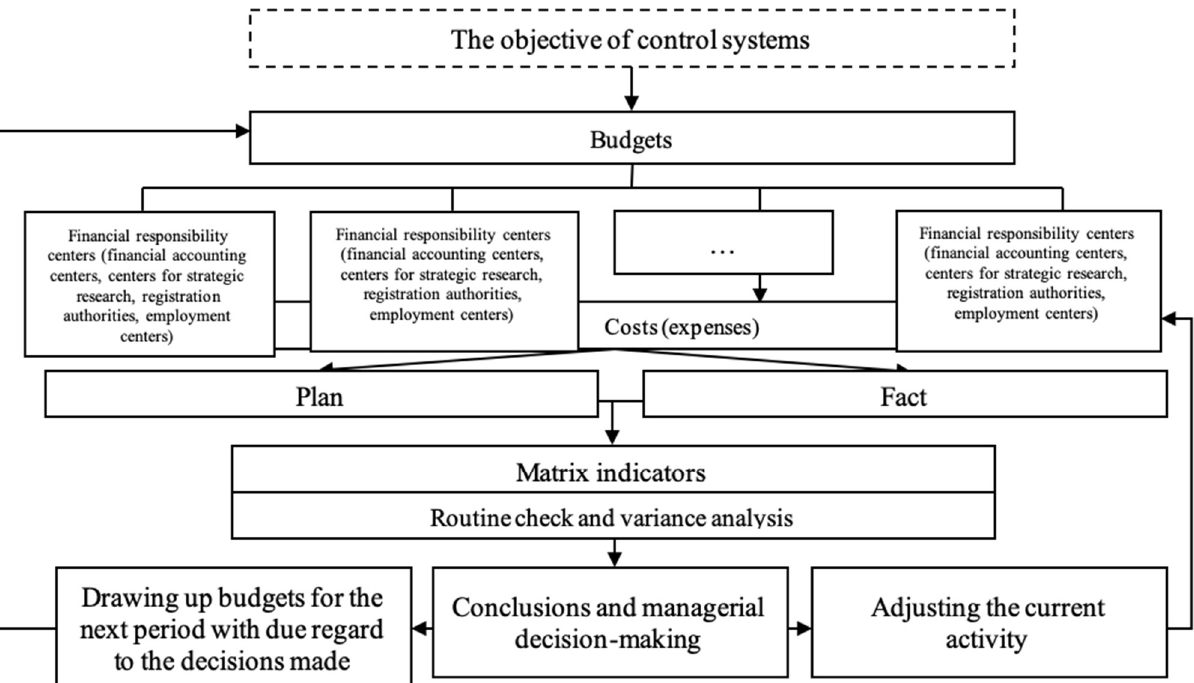
Figure 1. The mechanism of budget management in the controlling